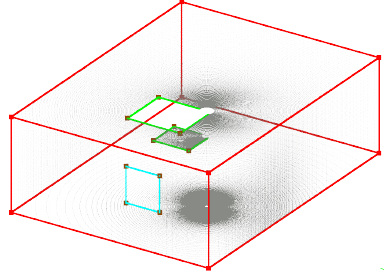
Figure 10. Contour segments of the polygons and corners detected by our method, superimposed on the point cloud from a LiDAR simulation in a synthetic scene. The edge labels are: intersection (red), occlusion (green) and opening (cyan). The corner labels are: intersection of three planes (red), intersection of two segments (brown)